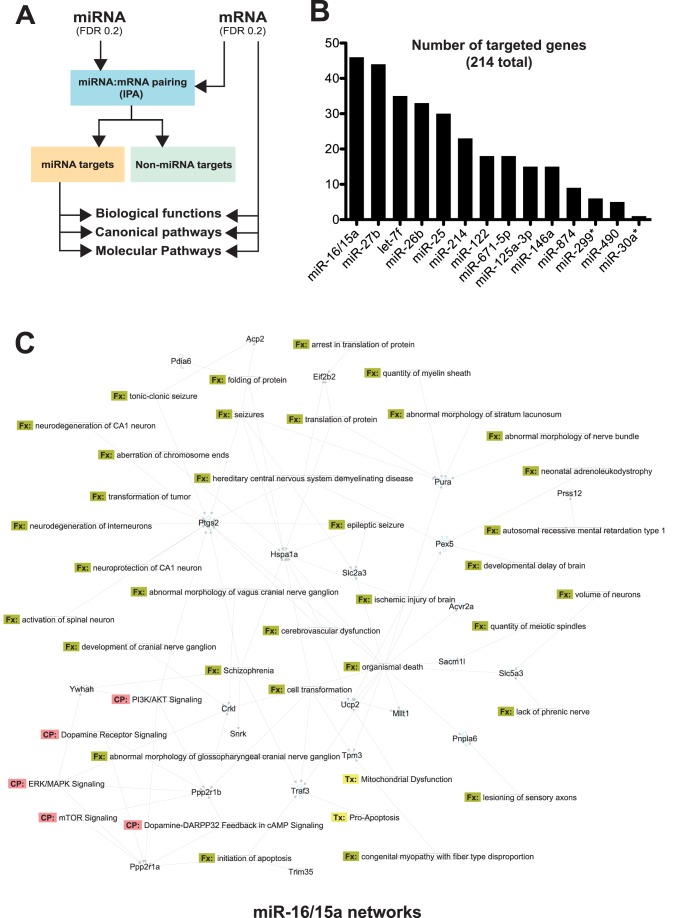
Bioinformatics analysis of LRRK2-dependent pathways.(A) Schematic overview of mRNA:miRNA pairing performed using the IPA software. This analysis allows the discrimination between potential miRNA targets and non-miRNA targets. The generated lists of genes are then processed for biological and functional significance. (B) Number of IPA-generated mRNA:miRNA pairings. Thirteen misregulated miRNAs (from a total of 24) are predicted to regulate 214 genes (from a total of 671). The top-ranking miRNAs are miR-16 and miR-15a, which harbour the same seed sequence (GCTGCT), and thus functional mRNA binding site. Changes in miR-16/15a levels were confirmed by qRT-PCR. (C) Shown here are statistically significant (P<0.05) IPA-generated networks. Both upregulated and downregulated genes predicted to be regulated by miR-16/15a were included in the analysis. Highlighted pathways are relevant for brain function and disease. The image was generated using the IPA software.